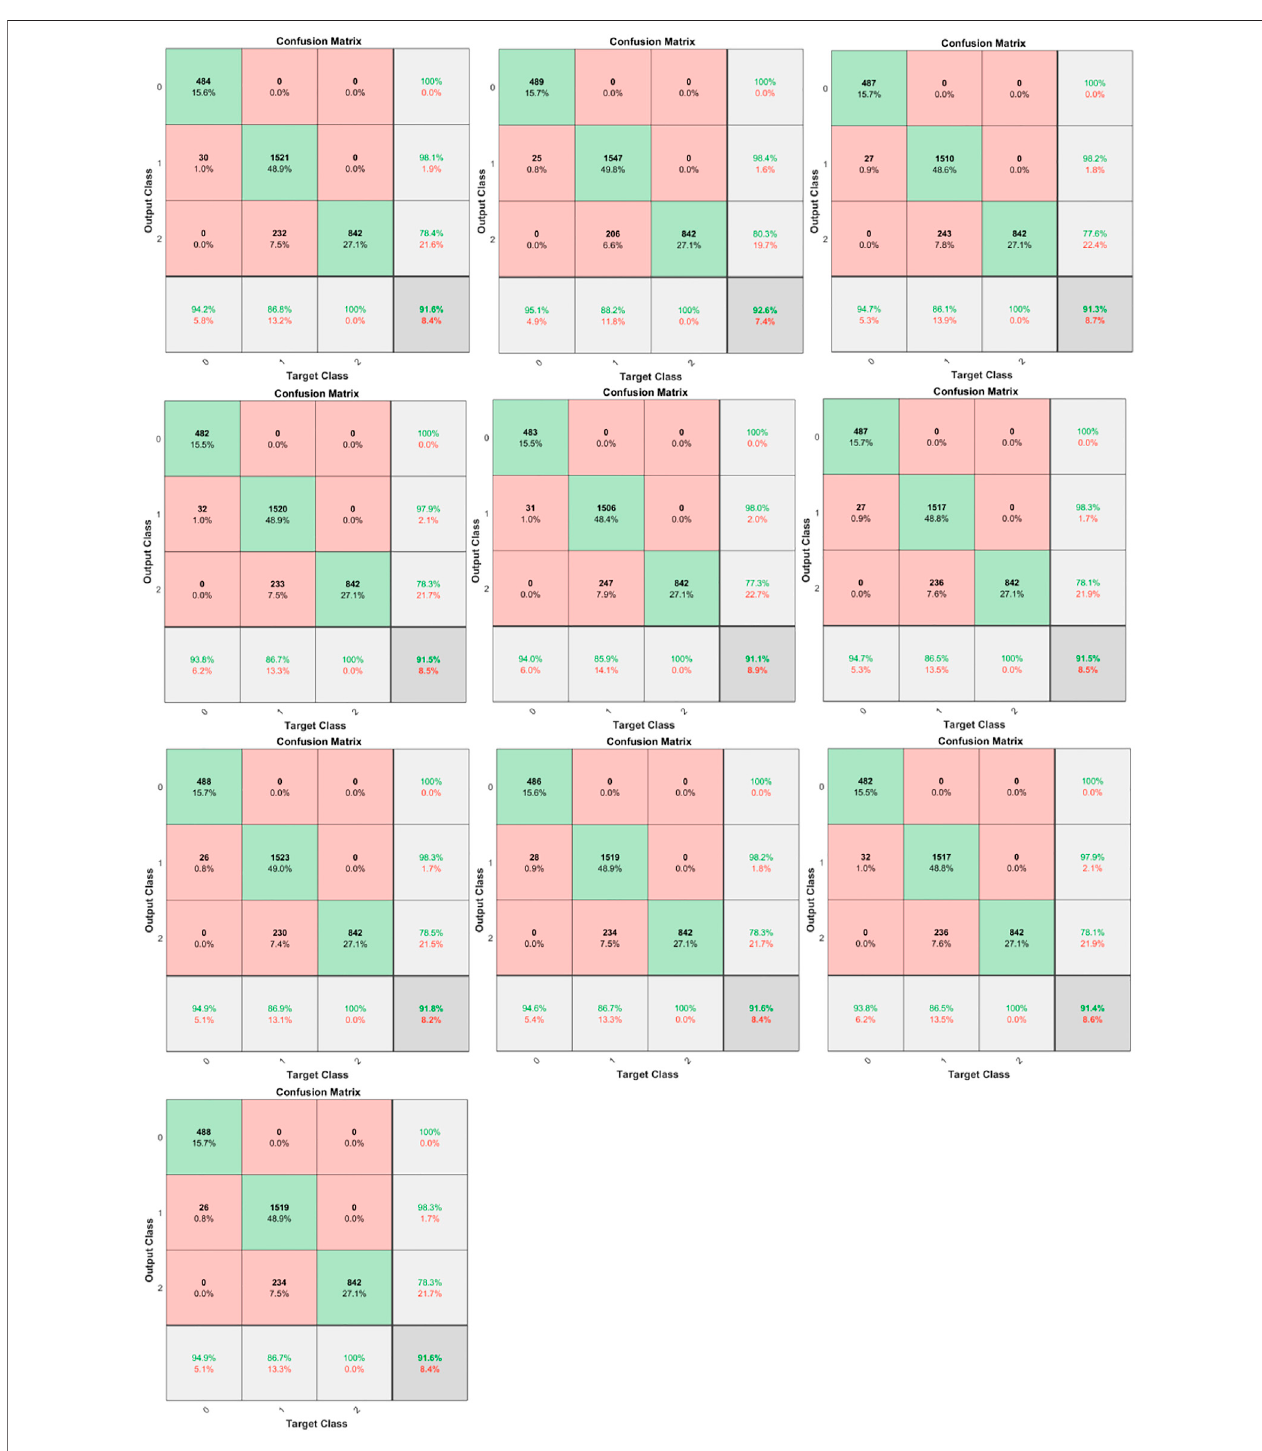
FIGURE 11 | Confusion matrixes of 10 times ’ training